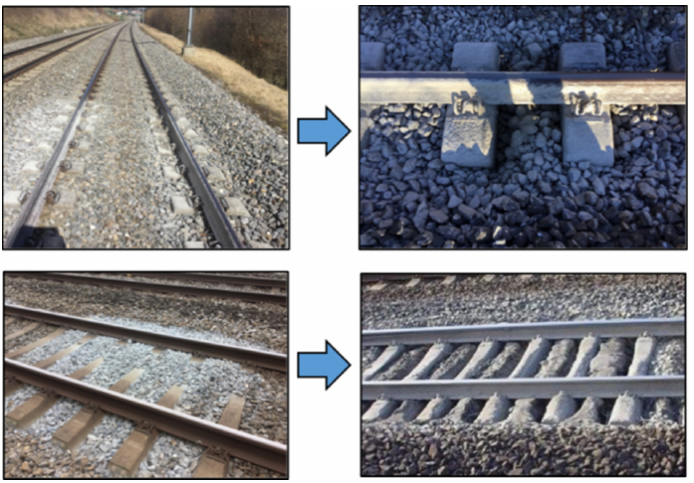
Figure 1. Poor sleeper support conditions and their consequences: ballast pulverization ( left ) and ‘mud pumping’ places ( right ).